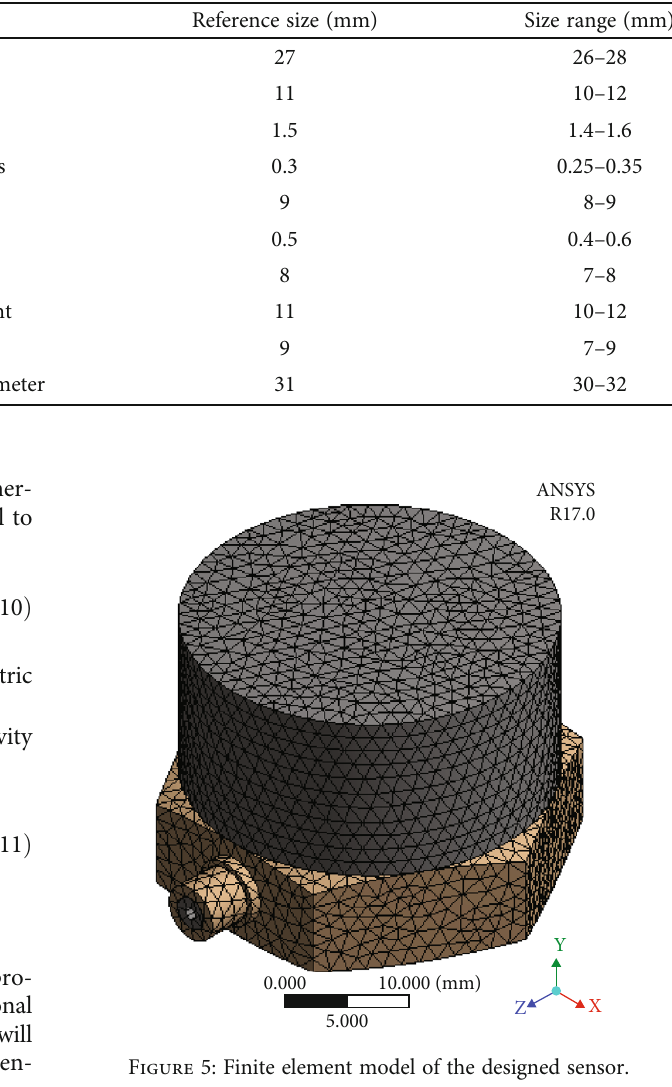
Table 3: Ten design variables and their size